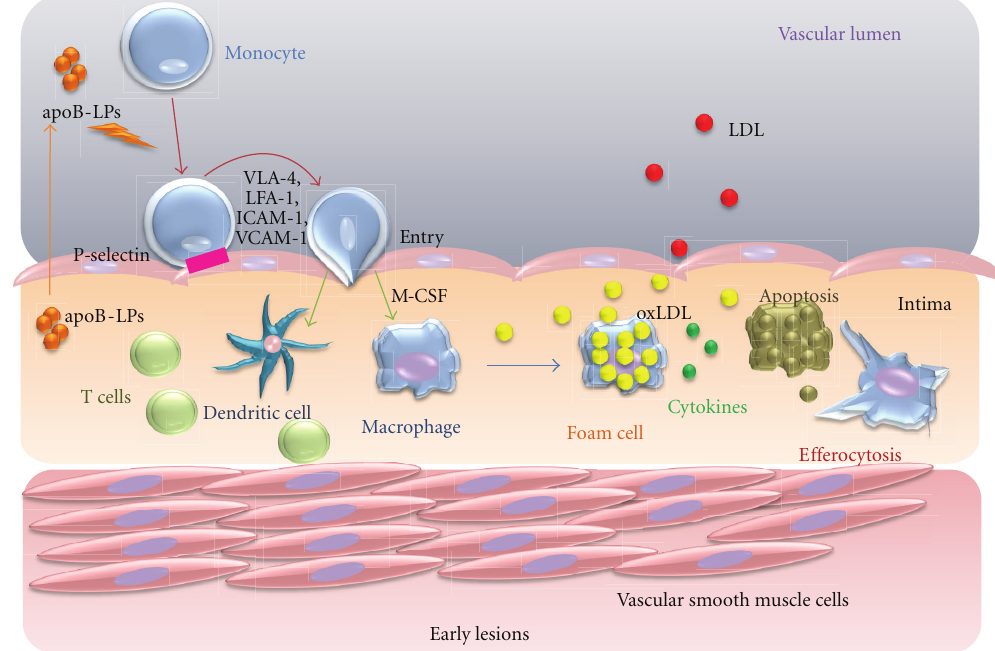
Figure 1: The roles of M1 and M2 macrophages. Ly6C high monocytes di ff erentiate into M1 type, classically activated macrophages that a ff ect proteolysis and produce antibacterial products. Ly6C low monocytes di ff erentiate into M2 type, alternatively activated macrophages that are involved in wound repair and tissue remodelling. M1 and M2 cells secrete di ff erent cytokines that function in e ff erocytosis and the formation of foam